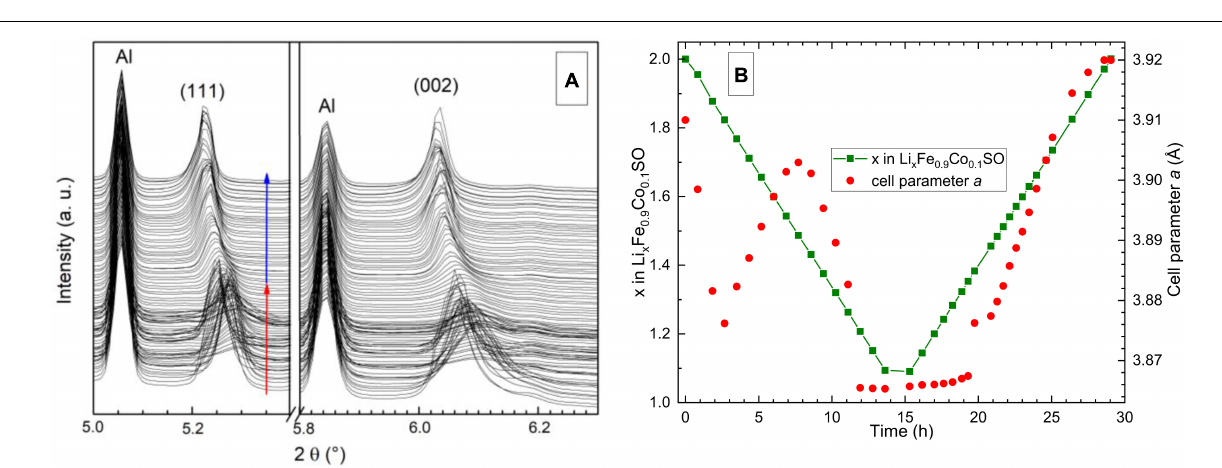
FIGURE 5 | (A) Part of X-ray diffractograms taken operando on DESY (Hamburg). Red arrows show charge and blue–discharge process. The wavelength was 0.20741 Å. (B) Cell parameter of Li 2 Fe 0 . 9 Co 0 . 1 SO versus time, and the amount of lithium in the structure during operando XRD